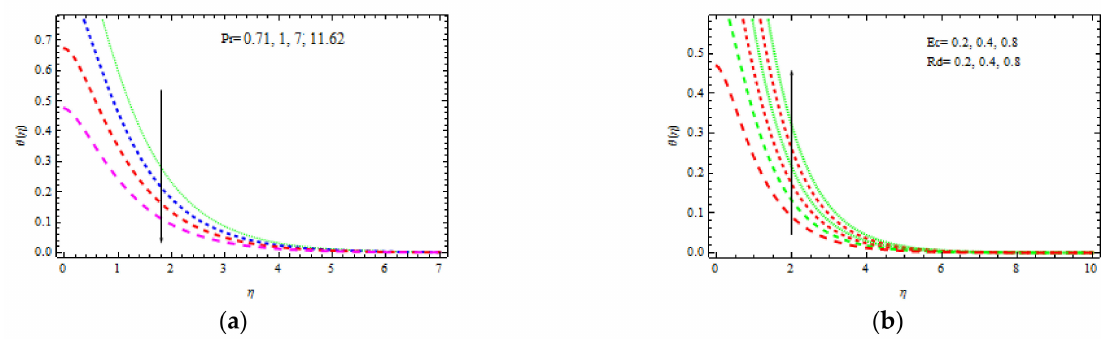
Figure 9. Inspiration of Pr ( a ) and Ec , Rd ( b ) on temperature.